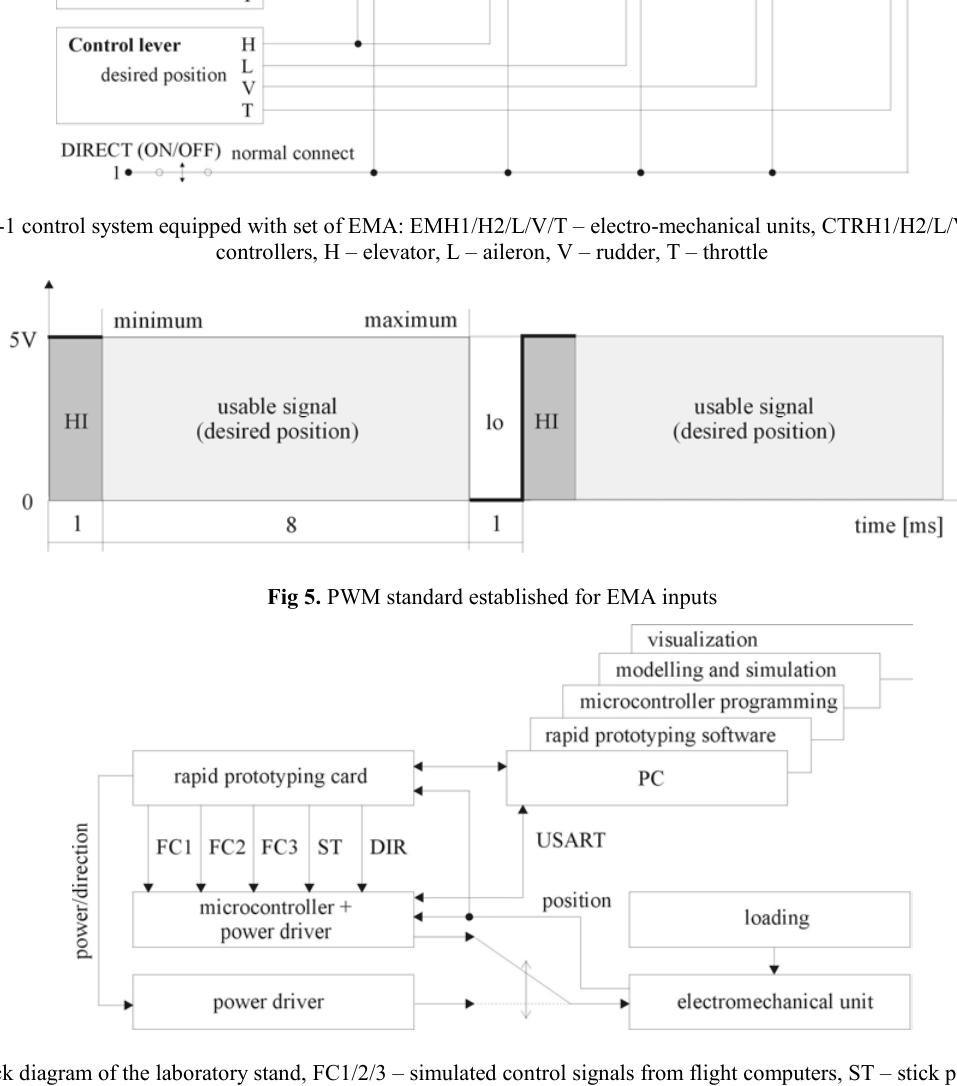
Fig 6. Block diagram of the laboratory stand, FC1/2/3 – simulated control signals from flight computers, ST – stick position signal, DIR – direct control switch, USART – Universal Synchronous Asynchronous Receiver